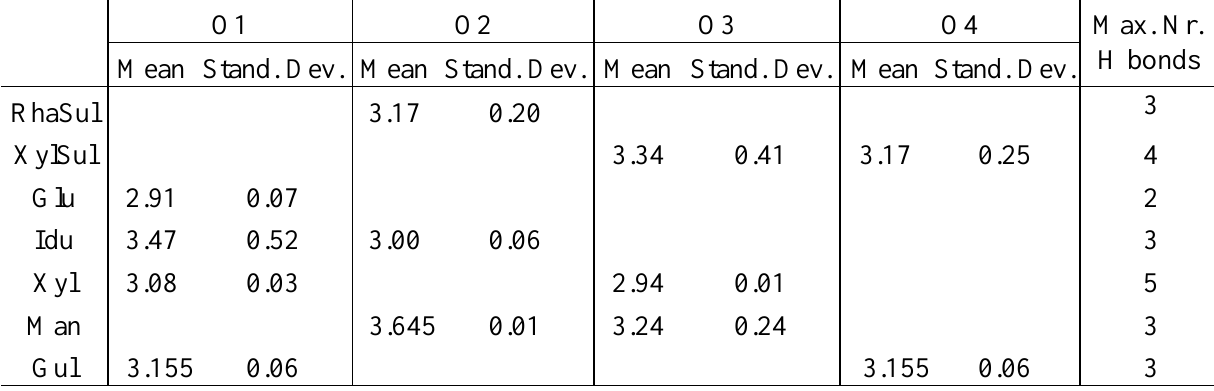
Table 4. Interatomic distances (Å ) between the calcium ion and the oxygen atoms of the ligands, and maximum number of H bonds for the three conformations of each ligand.